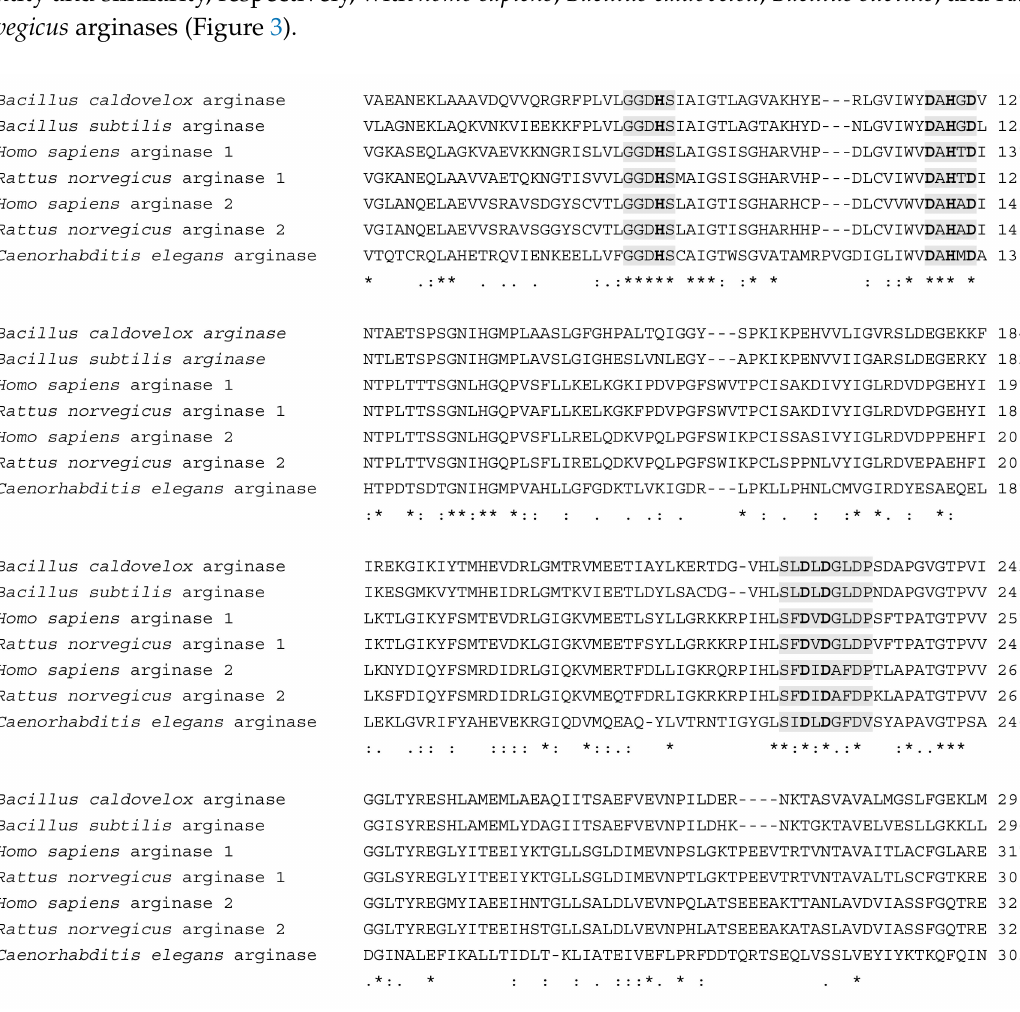
Figure 3. Amino acid sequence alignments of arginases and putative arginase T21F4.1 in C. elegans